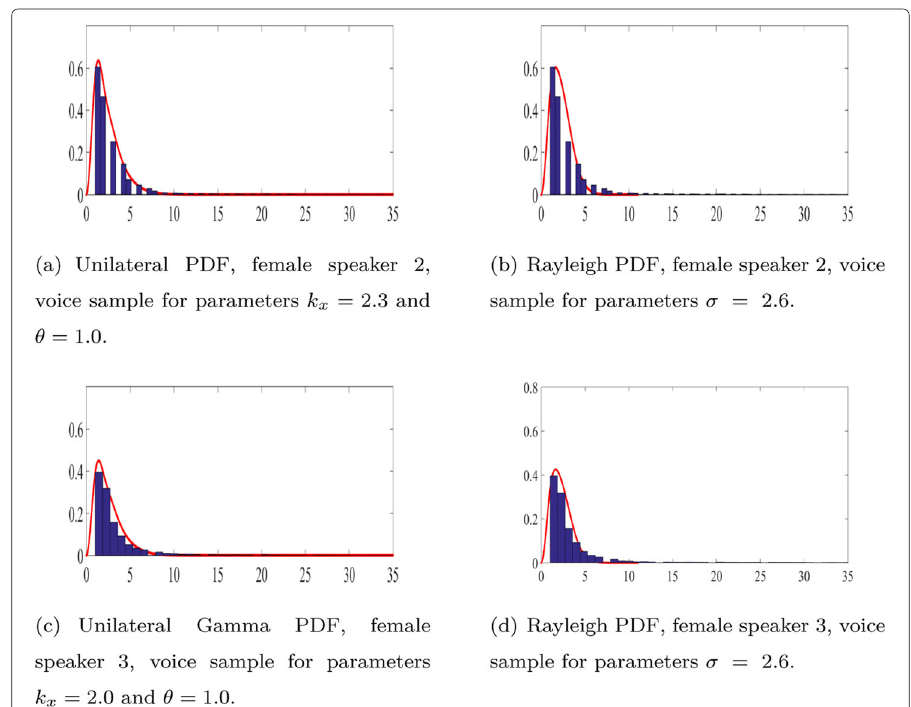
Fig. 4 PDF curves of Rayleigh and unilateral gamma distributions superimposed to histograms generated from voice samples of female